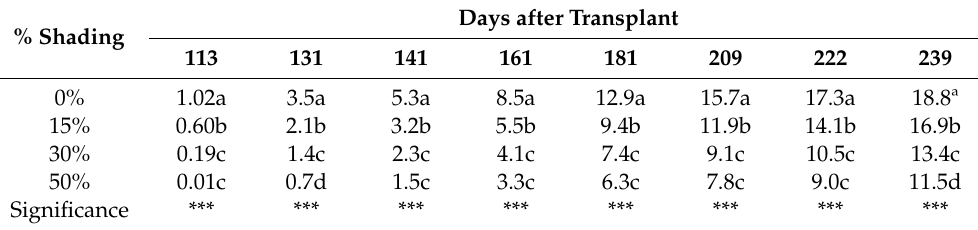
Table 1. Effects of shadow treatments in the total accumulated yield (kg · m − 2 ) in a tomato crop. Days after Transplant % Shading